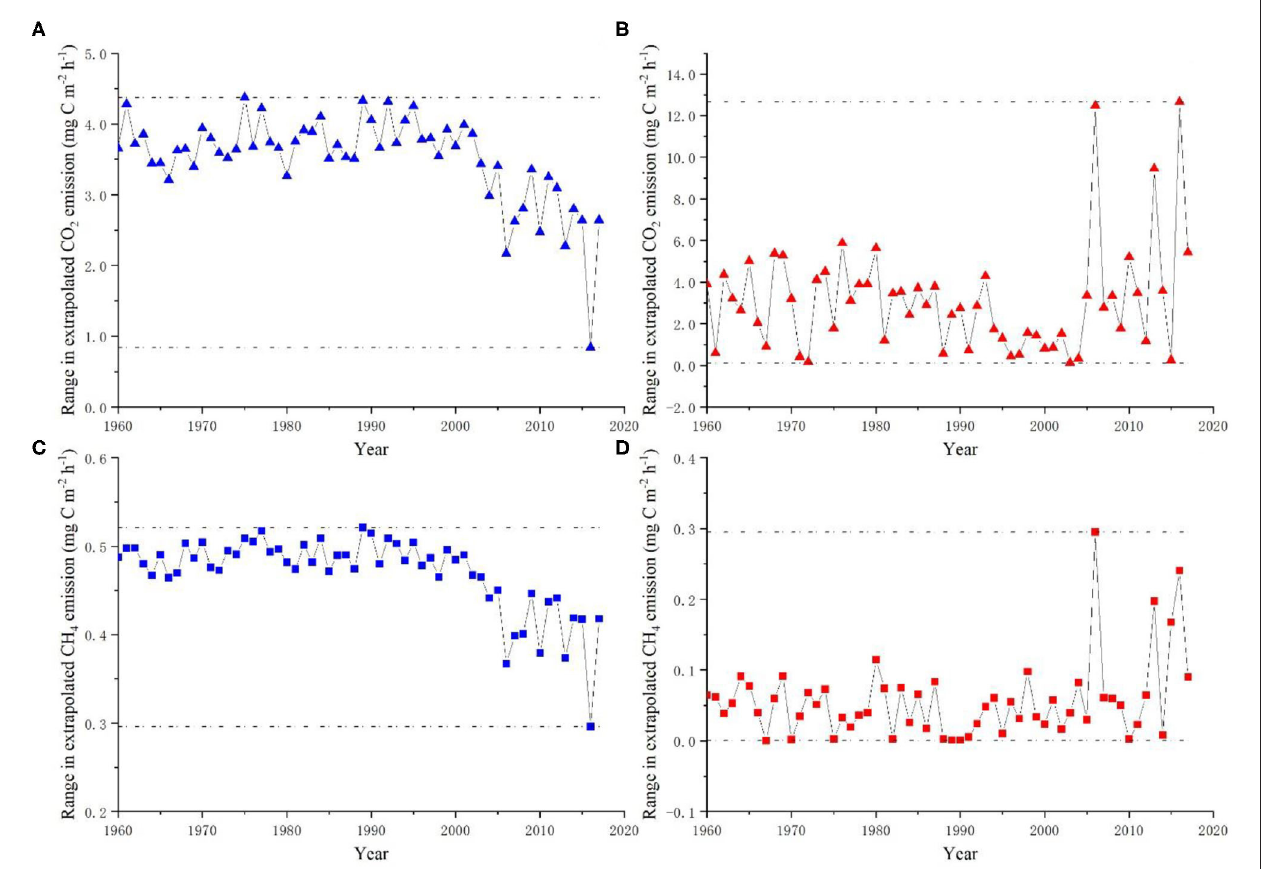
FIGURE 5 | Calculated differences between extrapolated annual greenhouse gas emission rate of study site from 1960 to 2017. CO 2 and CH 4 emission rates were extrapolated by models based on data derived from the static chamber method (A,C) or Eddy covariance method (B,D) at annual and NG&G seasonal timescales, respectively. The differences between the maximum and minimum extrapolated values of each year were plotted.